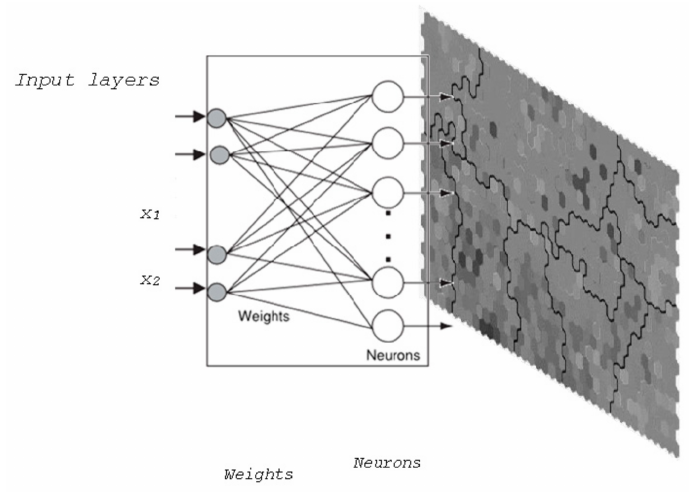
Figure 9. SOM representation. Source: Recknagel (2006) and author